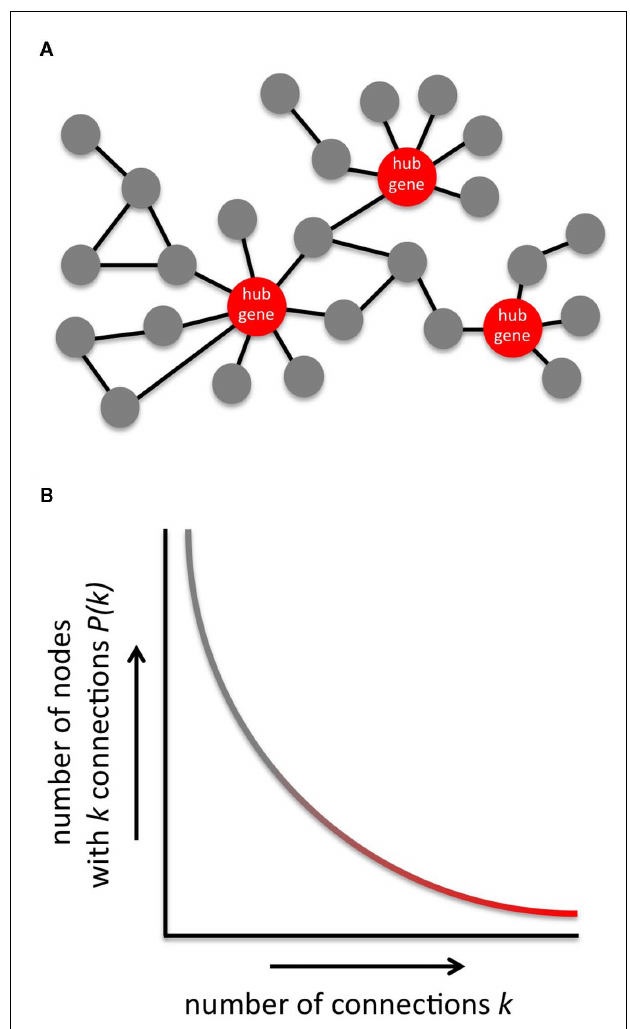
FIGURE 1 | General structure of gene networks. (A) Typical example of a gene network. Highly connected genes (indicated in red) are referred to as hub genes. (B) Gene networks, like most other biological networks and many non-biological networks too, are scale-free.The connectivity distribution P ( k ) in a scale-free network follows an inverse power relation with number of connections k per node. Consequently, gene networks contain many nodes with low connectivity (gray part of the curve), whereas only a few nodes are highly connected and qualify as hub genes (red part of the curve). Scale-free networks are robust against random perturbation. This protects gene networks from falling apart as a result of random mutations, but it is at the same time the Achilles’ heel of a gene network because targeted attacks at network hubs will quickly result in network fragmentation and deregulation of large groups of genes. Hub genes are therefore interesting candidate targets to efficiently interfere with cellular